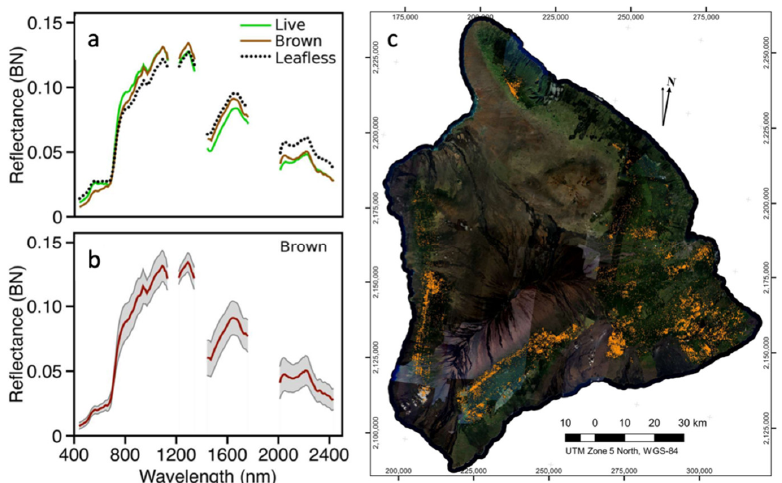
Figure 3. In order to map and monitor Rapid Ohi’a Death (ROD) across the landscape, ( a ) the brightness-normalized mean spectra of live, brown, and leafless ohi’a trees were extracted from Global Airborne Observatory (GAO) data. ( b ) The mean and standard deviation spectra of brown (potential ROD infestations) ohi’a were used to ( c ) map and quantify brown ohi’a crowns [54].